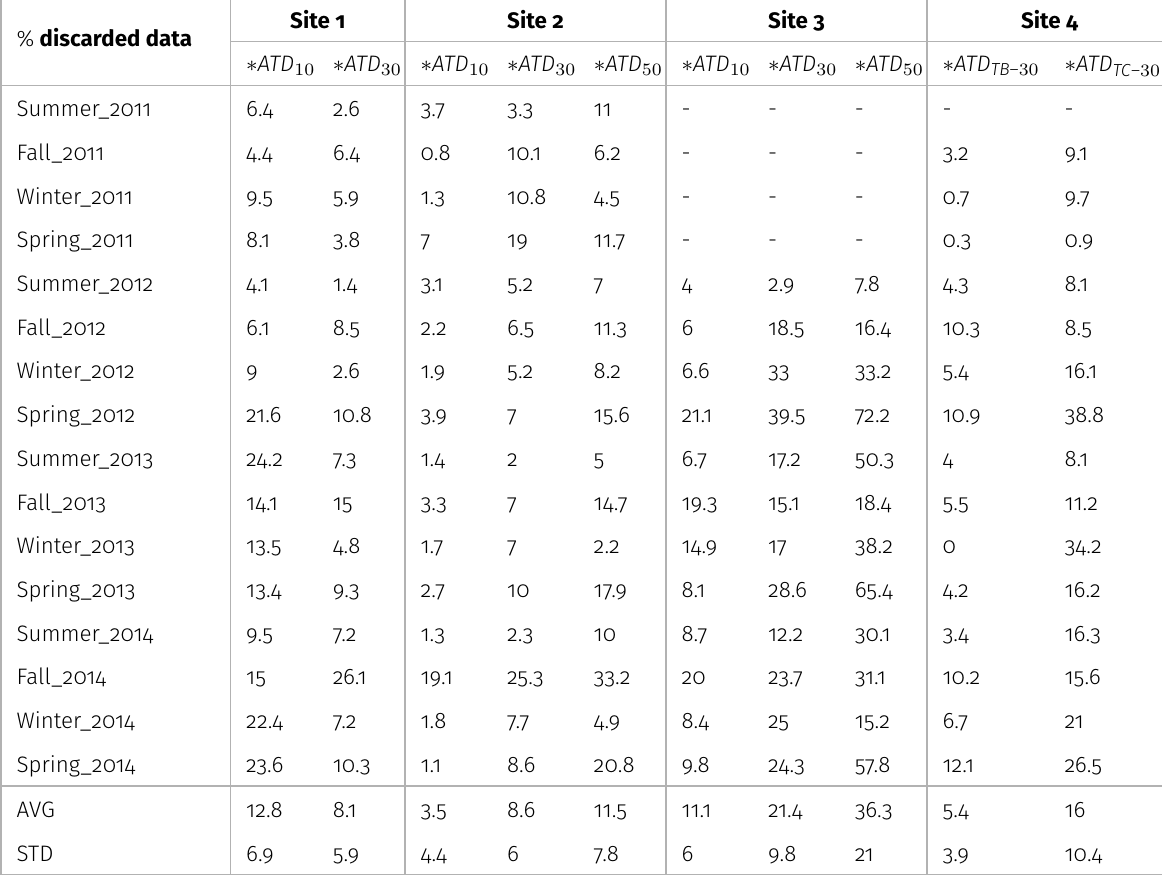
Table II. Percentage of discarded data of the temperature variation ( ∆ t ) in the different studied sites in Keller Peninsula, Maritime